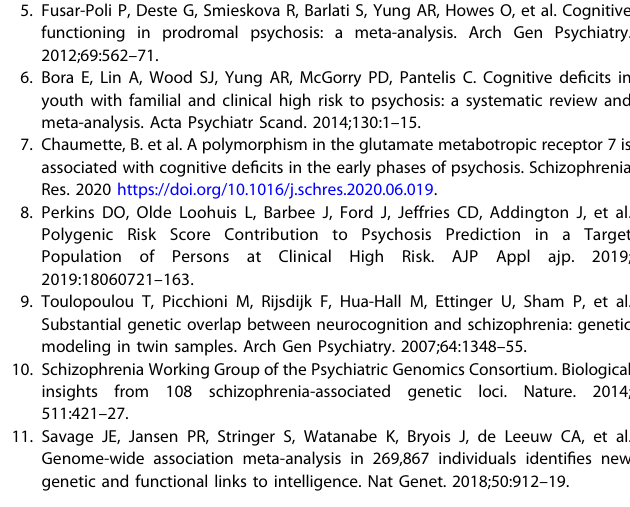
Genome-wide association meta-analysis in 269,867 individuals identi fi es new genetic and functional links to intelligence. Nat Genet. 2018;50:912 – 19.